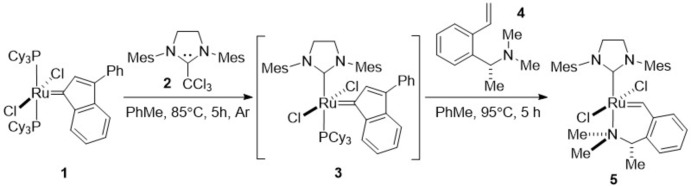
Reaction scheme.